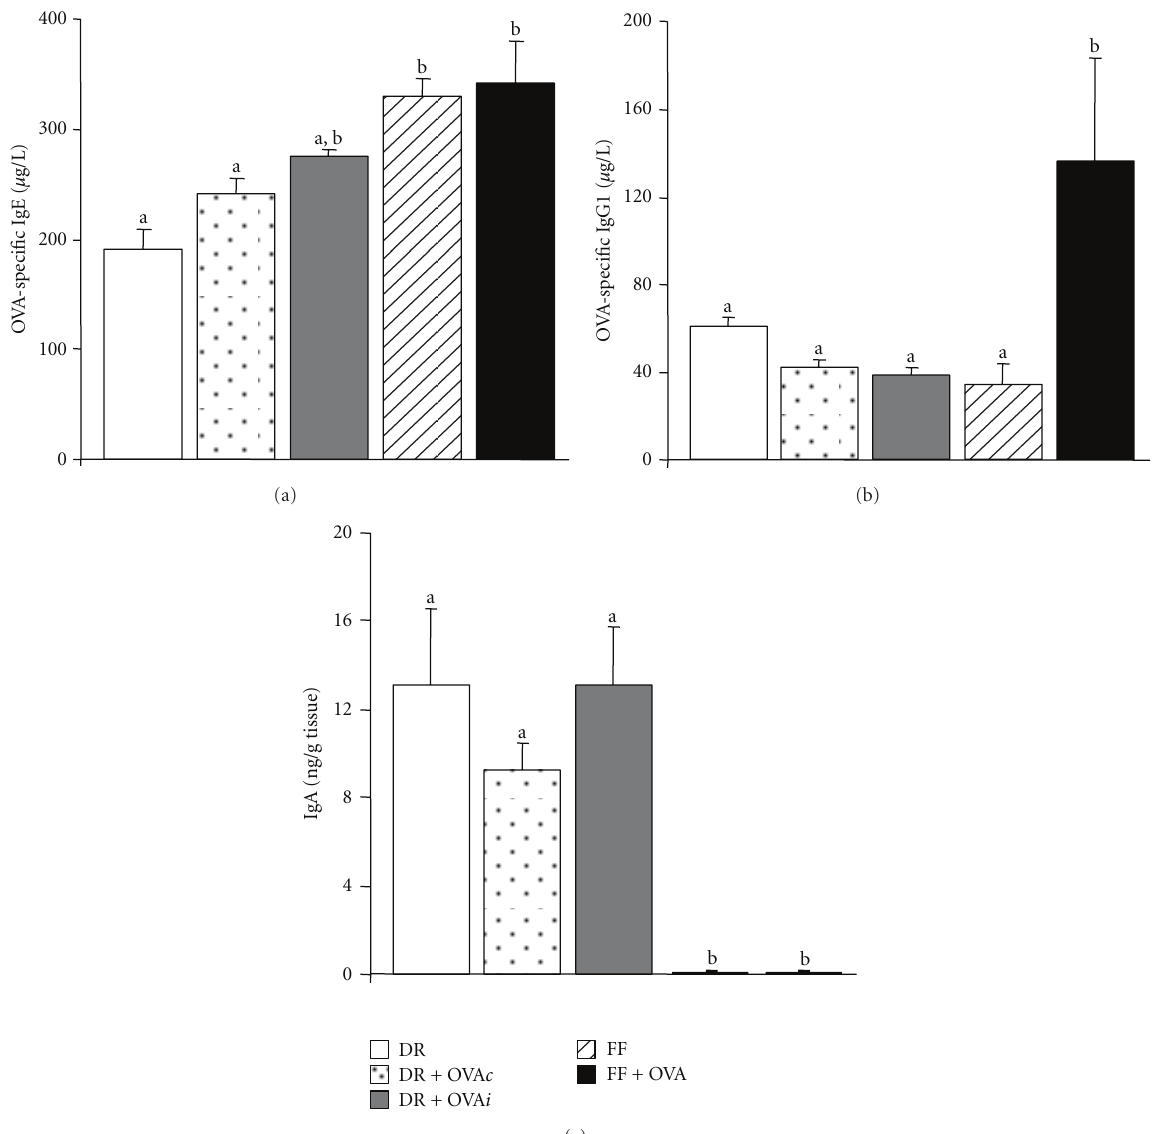
Figure 1: OVA-specific IgE, OVA-specific IgG1, and ileal IgA after oral OVA commenced at day 4 in DR or FF rat pups. Bars are mean + SEM, n = 8/group. Means without a common letter di ff er, P < 0 . 05.